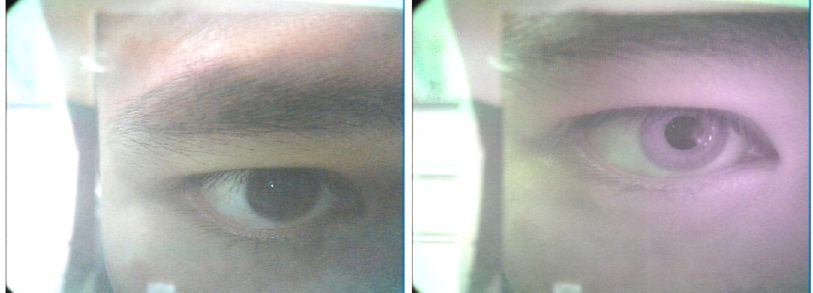
Figure 3. The left graph is the eye image captured when the near infrared light emitting panel is closed, while the right graph is when the light emitting panel is turned on. When the light emitting panel is turned on, the eye image has obvious dark pupil effect, and the image contrast is also enhanced.